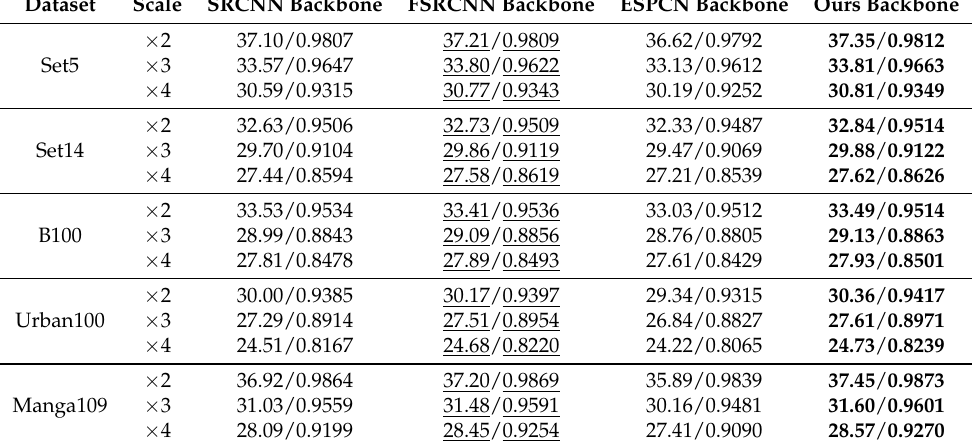
Table 1. The comparison of PSNR and SSIM [51] with different CNN backbone settings on benchmark datasets. Bold indicates the best performance, while Underline indicates the second best.